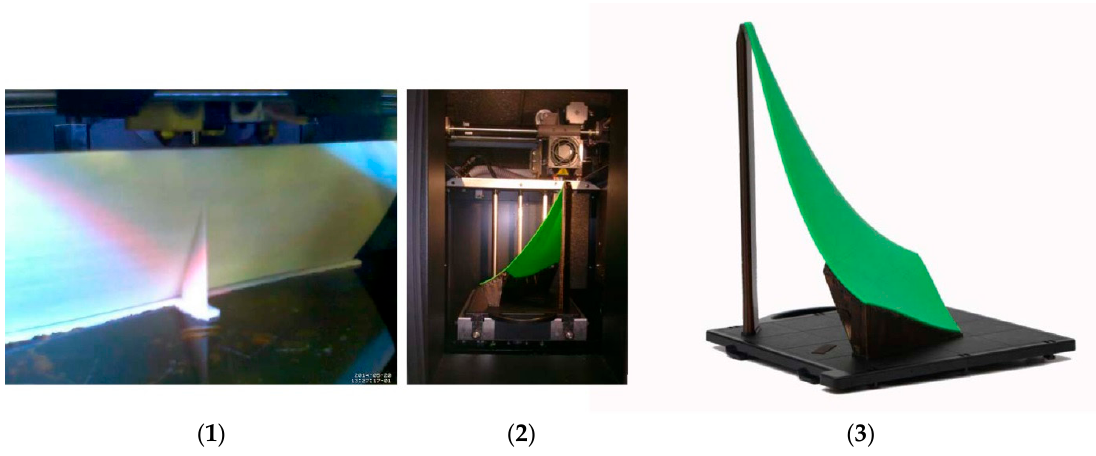
Figure 6. 3D printing: ( 1 ) printing on a Replicator 2X (MakerBot Industries); ( 2 ) piece printed on a Dimension SST760 (Stratasys); ( 3 ) final piece corresponding to one third of the shell with 2 mm